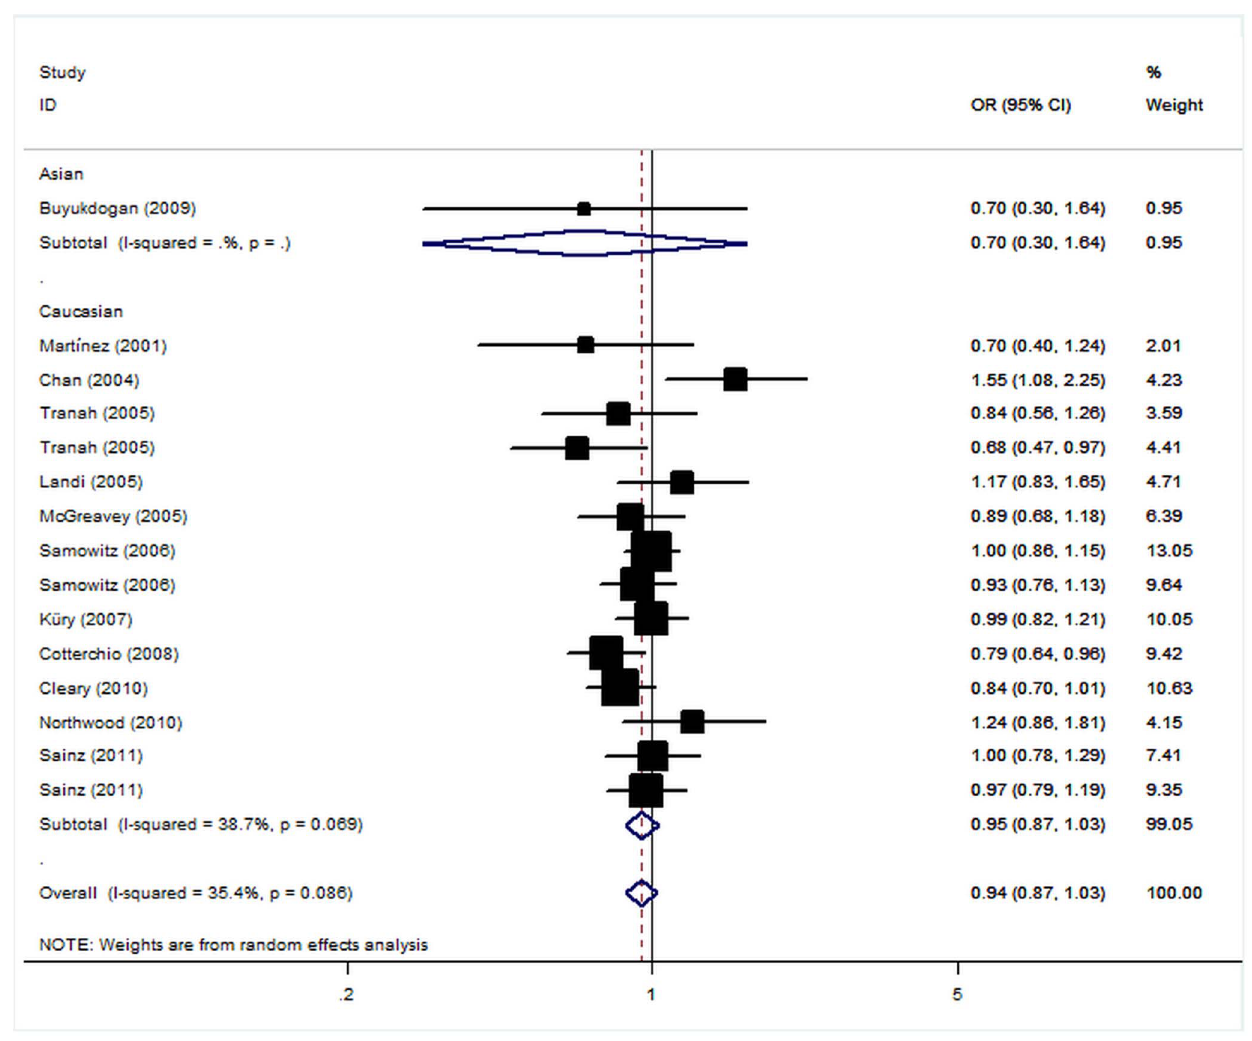
Figure 1. Forest plot (random effects model) of colorectal cancer risk associated with the CYP2C9 *2 carrier of the R144C polymorphism.